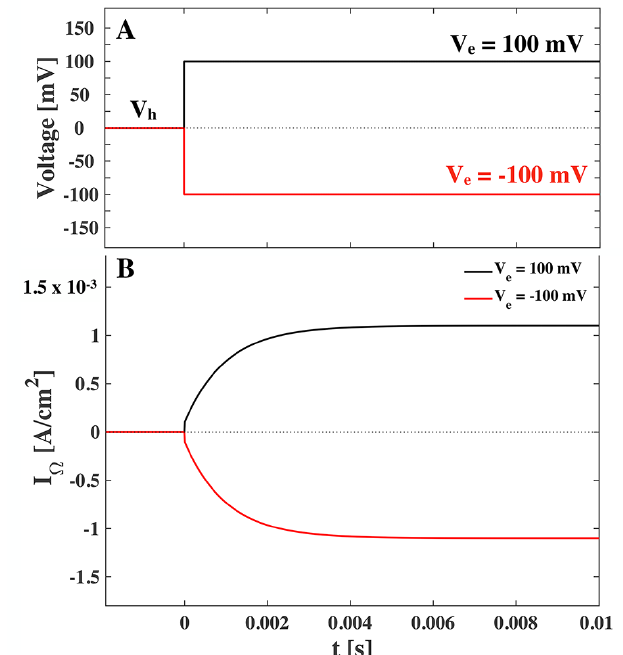
= 0 to an end voltage of h = − 100 mV (negative jump, red). ( B ). The e